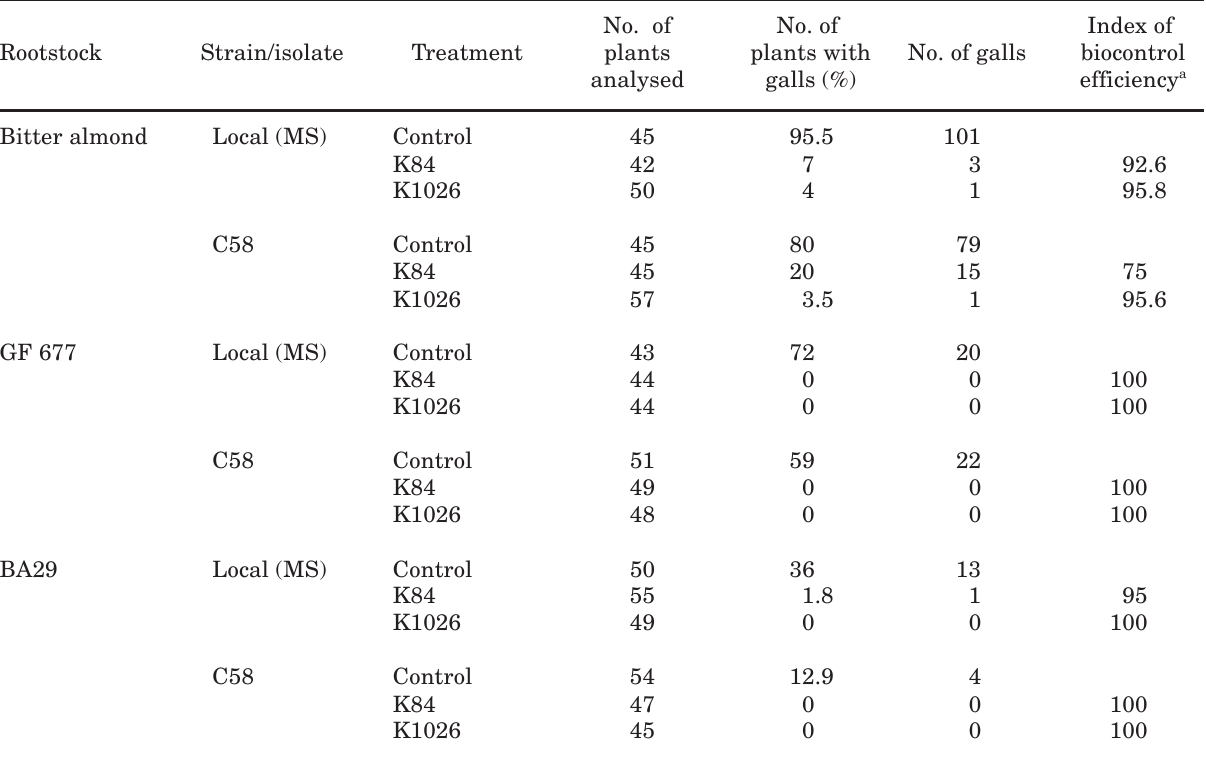
Table 5. Effect of the antagonistic Agrobacterium radiobacter strains K84 and K1026 on gall formation in potted